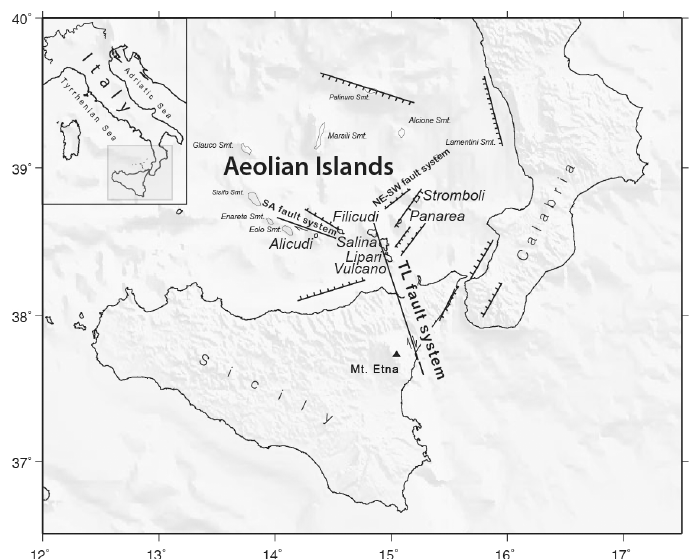
Figure 1. Tectonic setting of the Aeolian